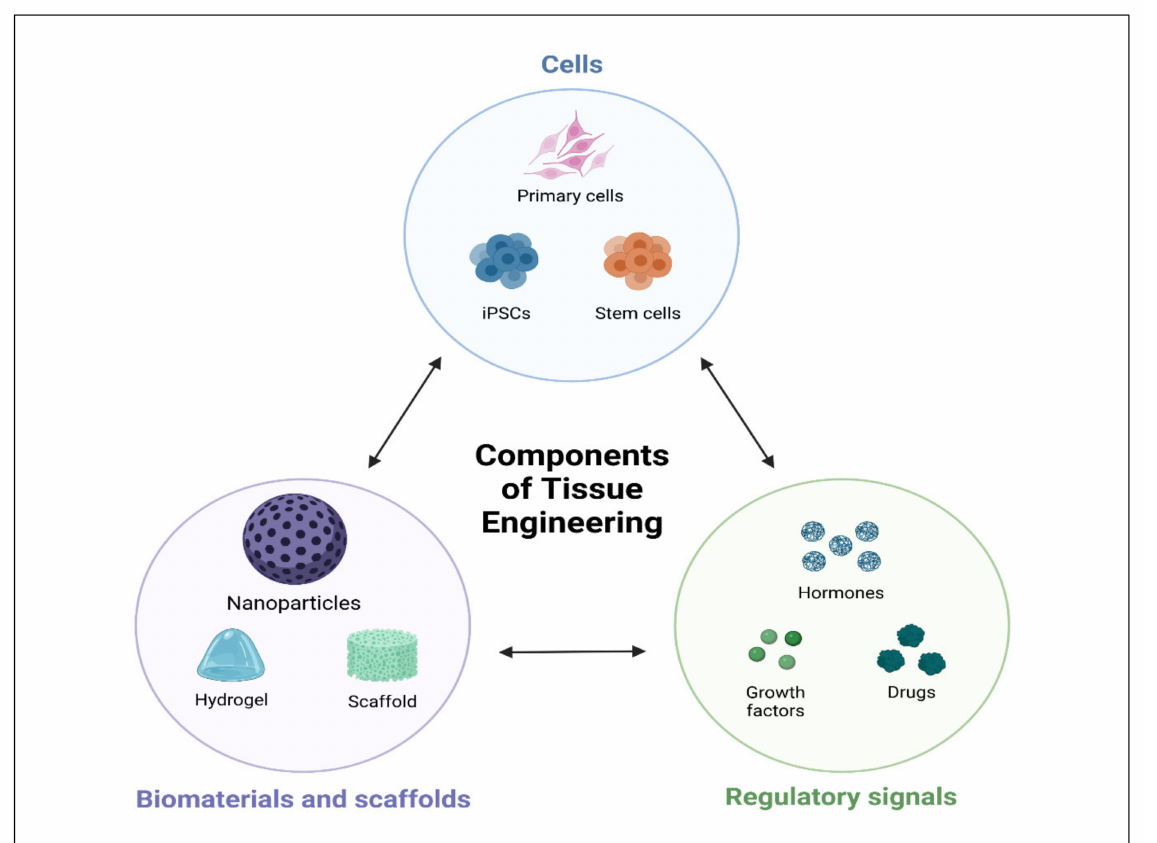
Figure 1. Schematic illustrations of tissue engineering triad. Cell, biomaterials, scaffolds, and regulatory